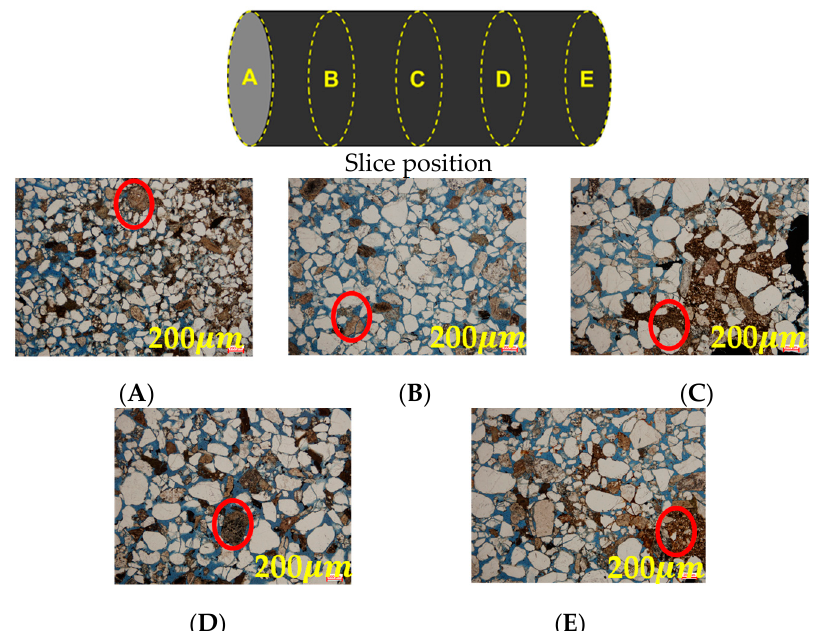
Figure 8. Rock slice images. ( A ), ( B ), ( C ), ( D ), and ( E ) are the core slice positions, respectively.